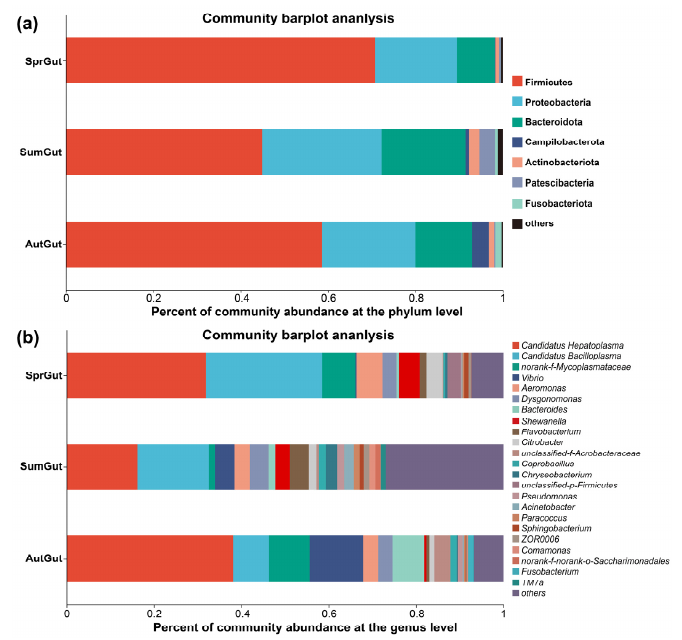
Figure 3. Composition of the bacterial community of Sinopotamon planum in the studied seasons (mean relative abundance > 1%). ( a ) At the phylum level; ( b ) at t the genus level.